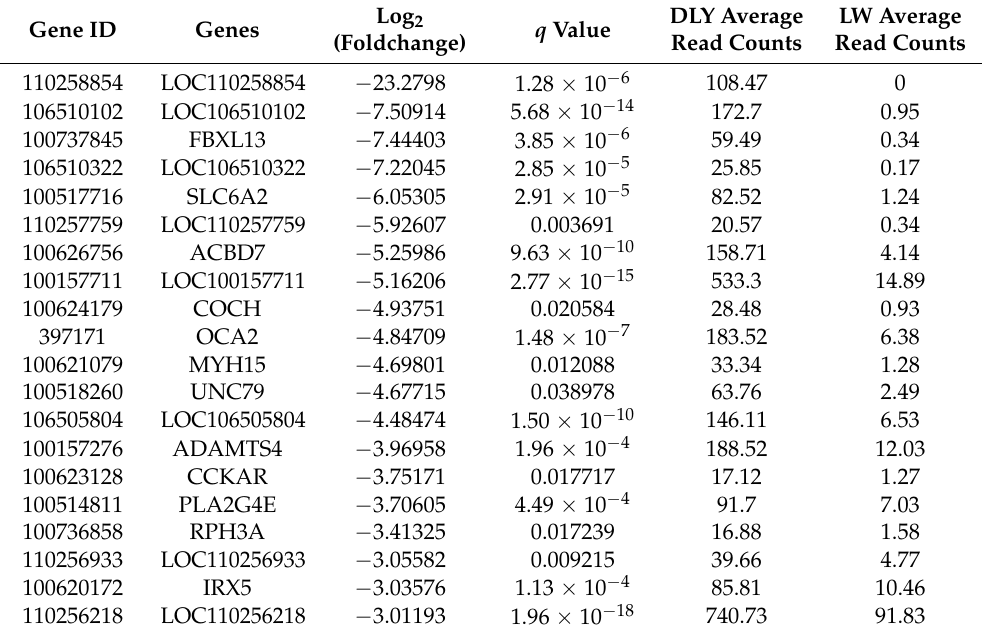
Table 4. The downregulated mRNAs in the Longissimus dorsi muscle sample of LW pigs according to q value threshold of <0.05 and log 2 (foldchange) < −